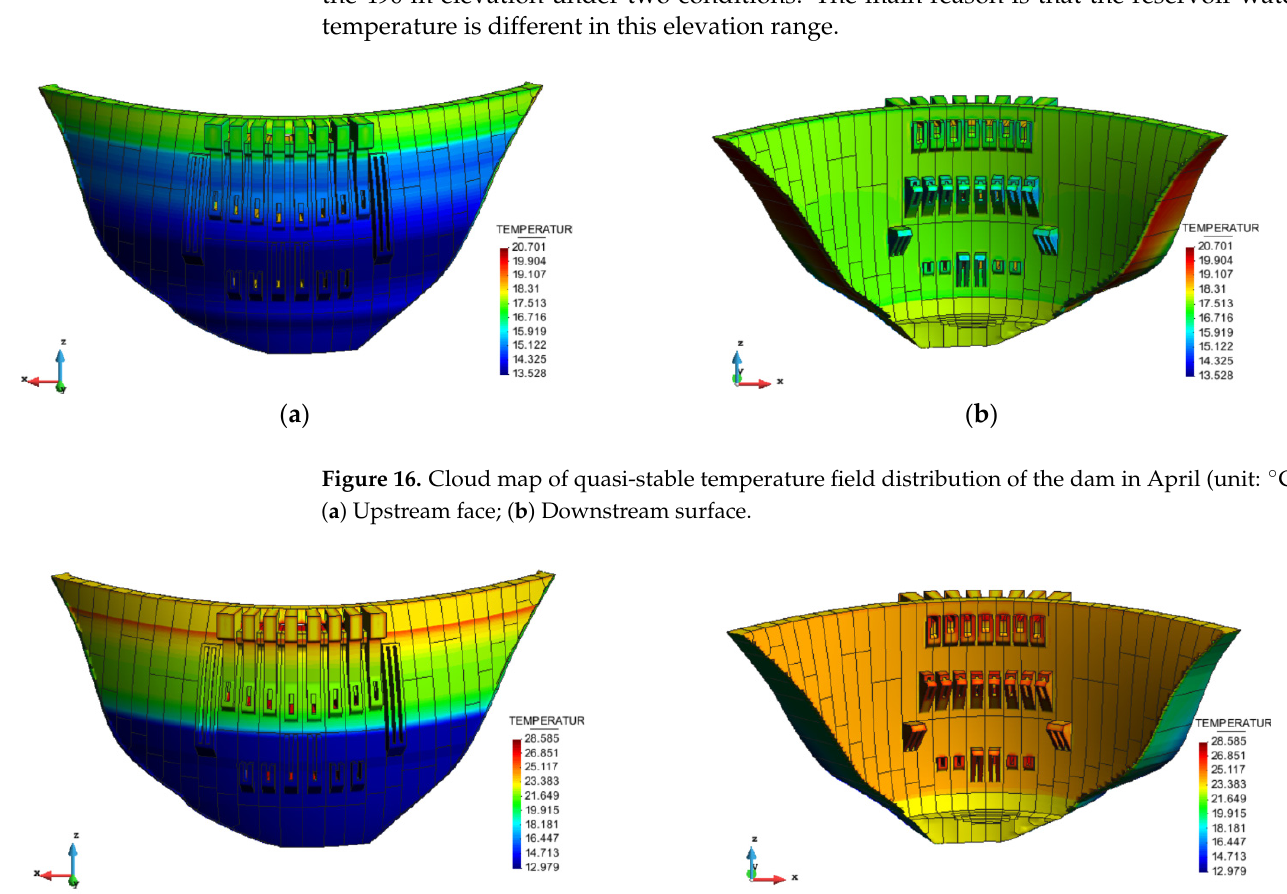
Figure 15. Cloud map of quasi-stable temperature field distribution of the dam in January (unit: °C). ( a ) Upstream face; ( b ) Downstream surface.